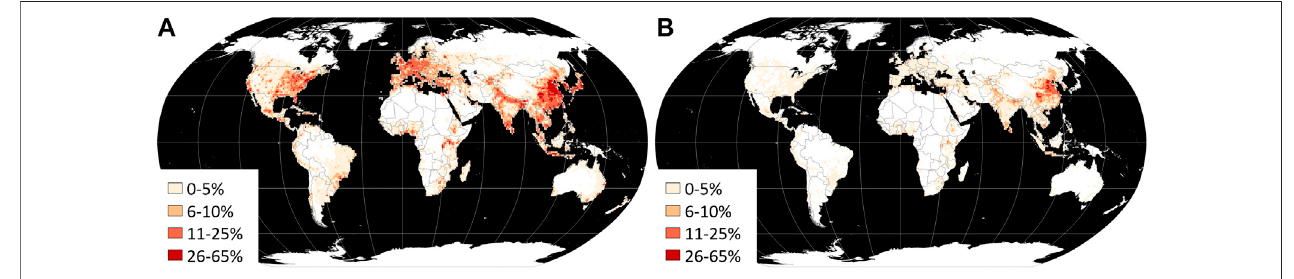
FIGURE 5 | Built-up lands and their net change for each 1 × 1 ° grid cell. (A) Built-up lands 2020, % cell area. (B) Built-up lands increase 2000 – 2020, % cell area.